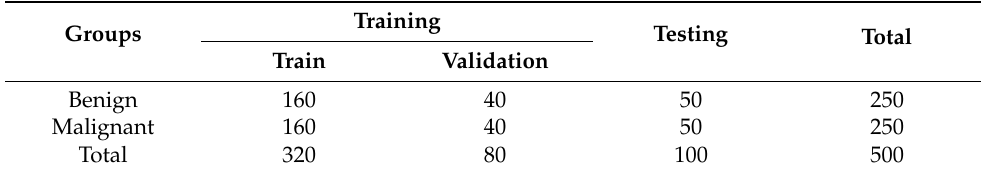
Figure 2. Microscopic biopsy images of a private dataset at the magnification factor of 40×. ( a ) Benign tumor. ( b ) Grade 3 tumor. ( c ) Grade 4 tumor. ( d ) Grade 5 tumor. Table 2. The numbers of benign and malignant images used for training and testing. Private dataset structure at 40× magnification factor.